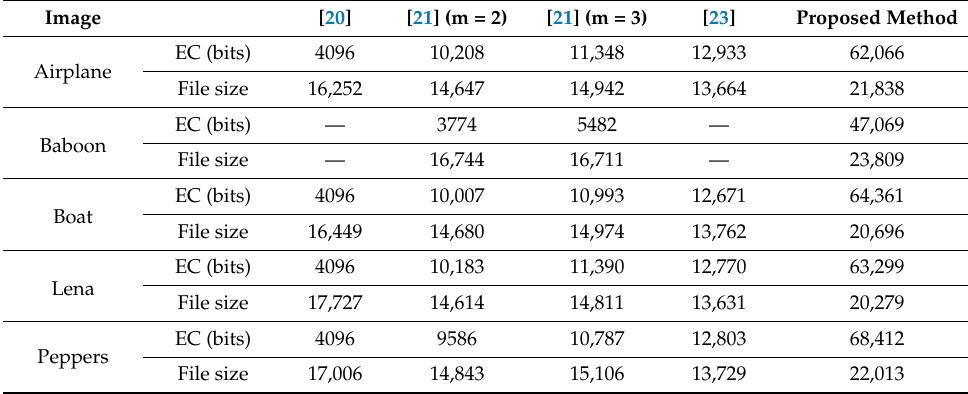
Table 7. Comparisons of EC and file size with SOC-based